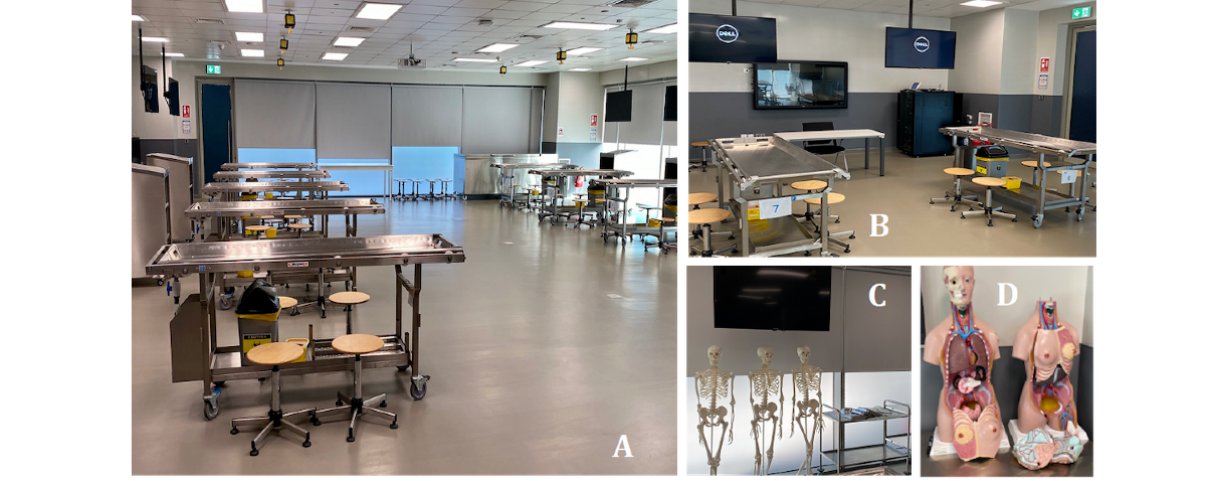
Figure 3. Anatomy dissection facilities at the Mohammed Bin Rashid University of Medicine and Health Sciences. (A) Dissection area showing the dissection stations (each station comprises an adult cadaver placed in the supine position on a removal tray situated on the dissection table); (B) medical imaging and case-based discussion area; (C) and (D) prosection